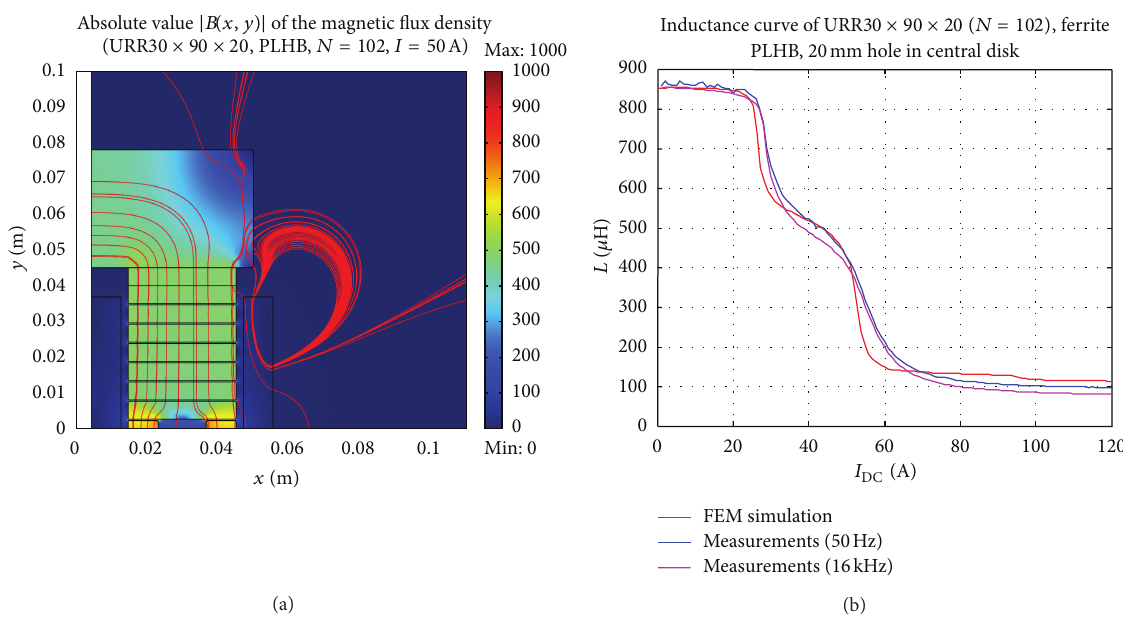
Figure 6: Distribution of the magnetic flux density |𝐵(𝑥,𝑦)| [mT] inside the URR 30 × 90 × 20 core (legs built up from ferrite disks with 30 mm diameter and circular cross-section, block yokes): (a) simulated and measured inductance curves, (b) (PLHB, 𝑁 = 102 , 𝐼 20 mm hole in central disk).